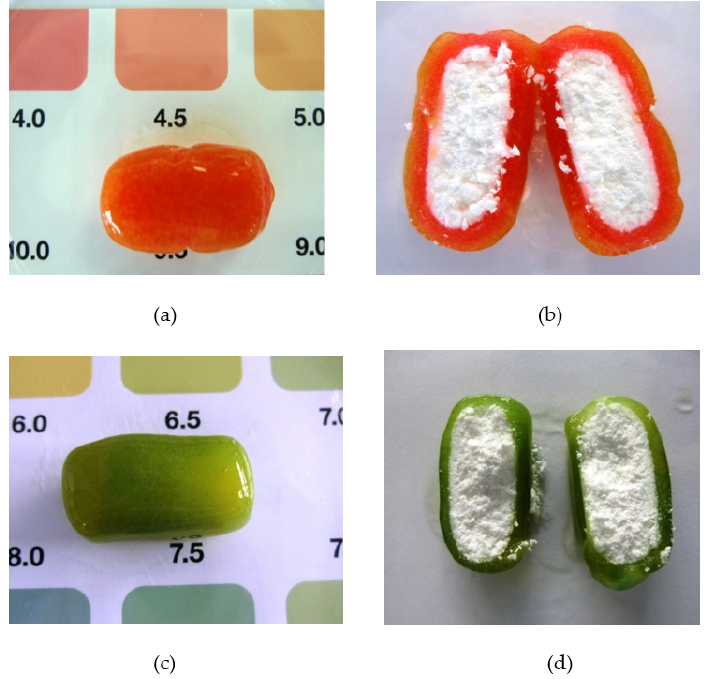
Figure 5. ( a ) Tablet hydrated for 3 h. ( b ) Tablet hydrated for 3 h, pH 4–5 halved to show dry core.